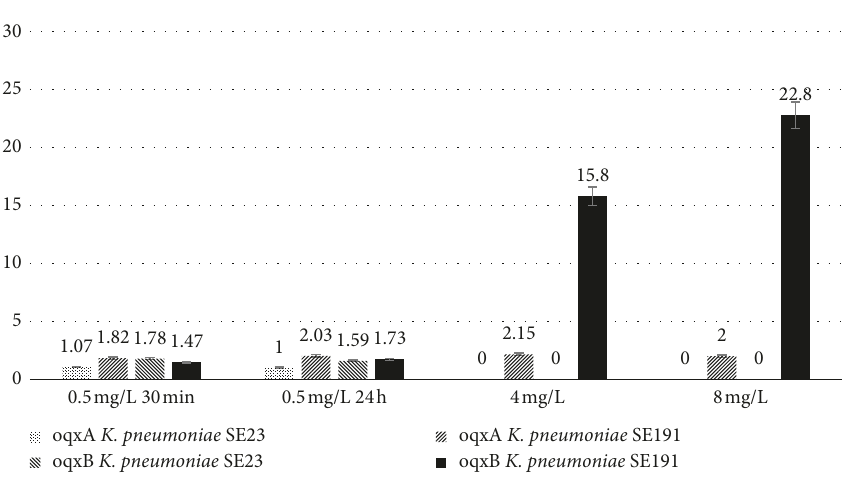
Figure 1: Expression in SE23 and